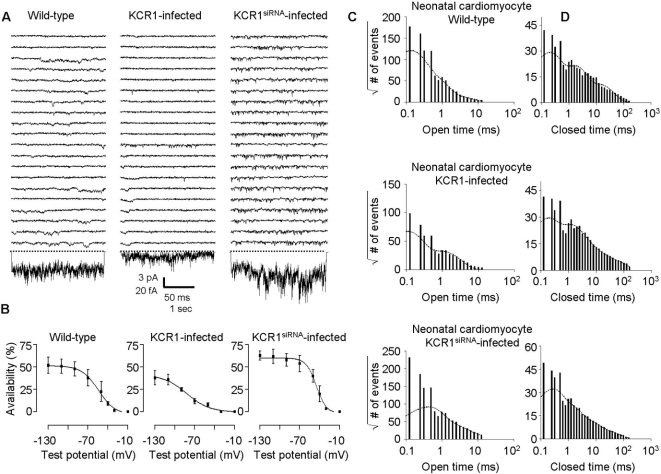
Effect of KCR1 and KCR1siRNA on single native If channel gating in one-channel patches.(A) Comparison between single native If channels of control neonatal ventriculocytes (left), KCR1-infected (middle) and KCR1siRNA-infected cells (right). Recording technique as in Figure 3. Scale bars, 50 ms, 3 pA for unitary current traces, and 1 s, 20 fA for ensemble average current. (B) Enhanced expression and knock-down of KCR1 significantly shifted the half-maximal activation of If to more negative and more positive potentials, respectively. Channel activation was measured by the parameter availability, plotted against the test potential and then determined by using the Boltzmann function. For data see text. (C) Open-time histograms: KCR1 exhibited no effect on the number of native If open states, whereas KCR1siRNA induced an increase of the number of open states. Number of open events (square root) were plotted against the logarithmically binned open time durations for If alone and with exogenous KCR1 or KCR1siRNA (pooled one- and multi [n≤3]-channel experiments). (D) Closed-time histograms: KCR1 did not affect the number of native If closed states, while KCR1 knock-down resulted in a loss of one closed state. Number of closed events (square root) were plotted against the logarithmically binned closed time durations for If alone and with exogenous KCR1 or KCR1siRNA (pooled one-channel experiments only).